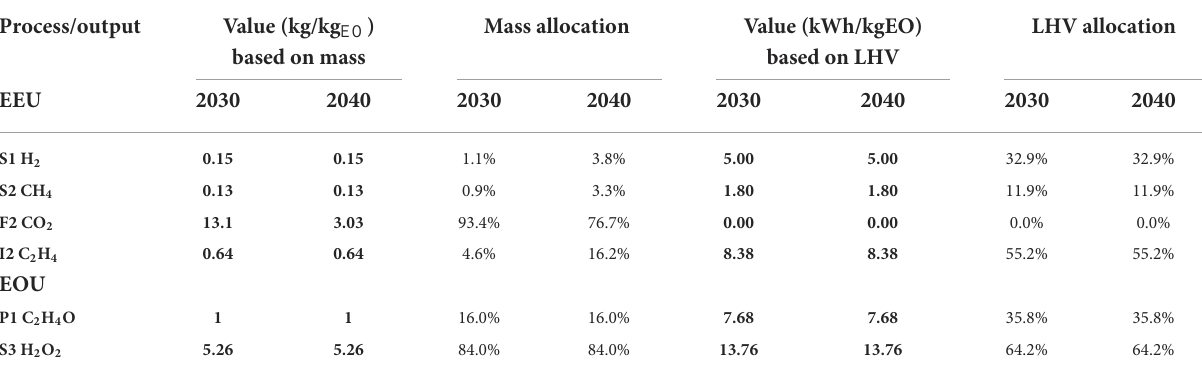
TABLE 4 Allocation factors for by-product allocation for the scenarios 2030 and 2040. Process/output Value (kg/kg EO ) Mass allocation Value (kWh/kgEO) LHV allocation based on mass based on LHV